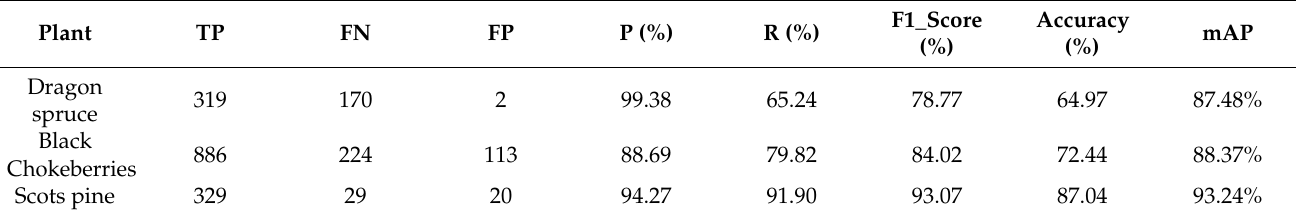
Table 4. The detection results of the model before augmentation.